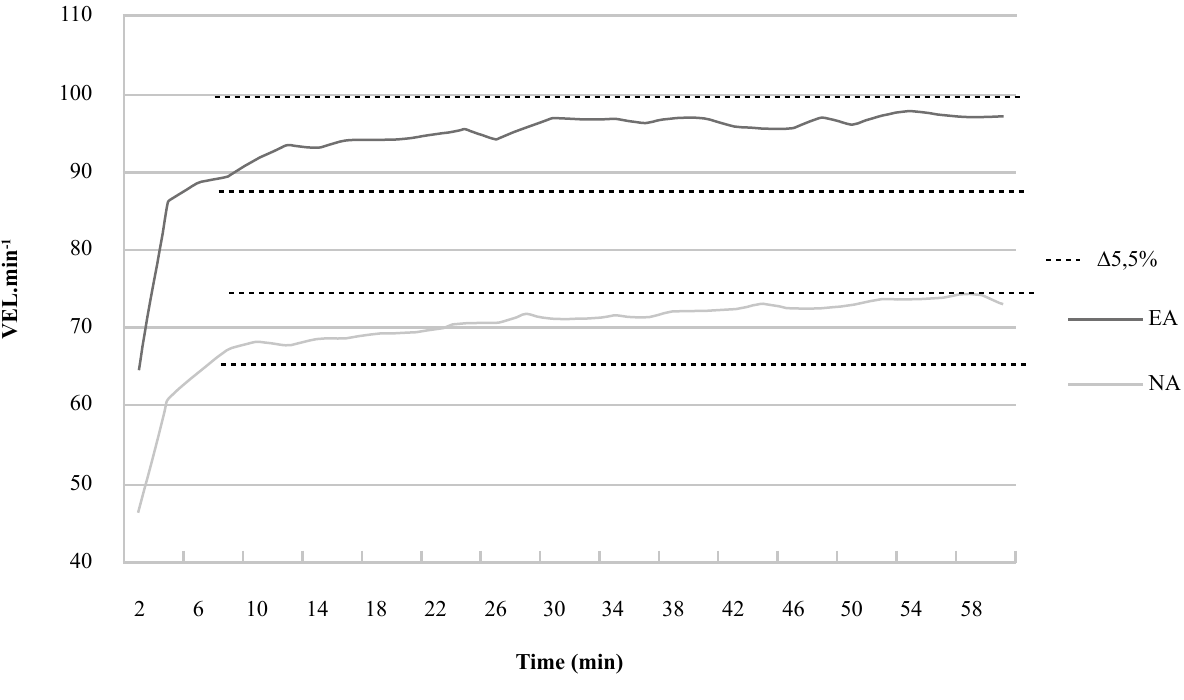
Figure 2− VE (L·min-1) during 1-hour exercise at vVAT in EA and NA (p > 0.05).